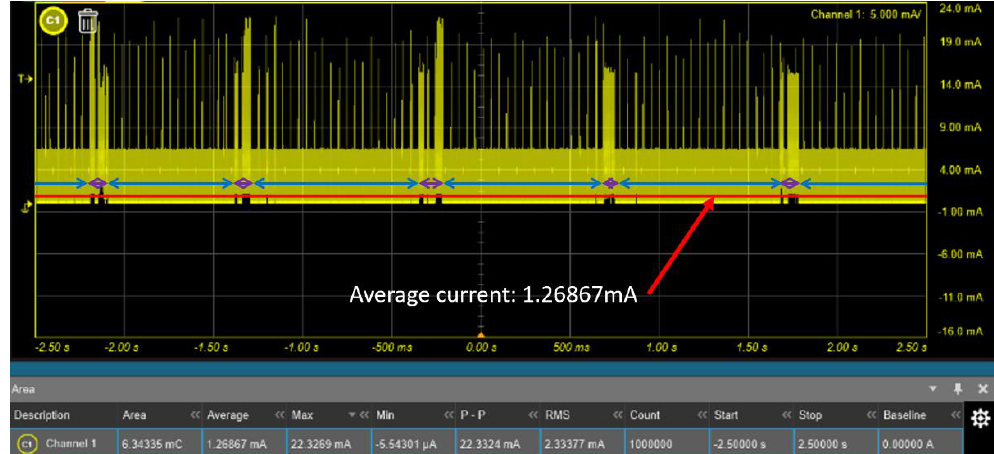
Figure 16. Current consumption of the surface EMG system. The blue line is only ADC conversion and the purple line is BLE transmission and ADC conversion.